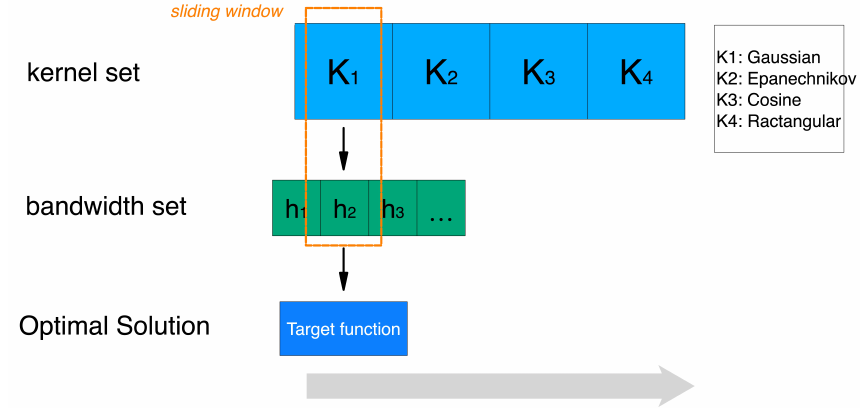
Figure 4. Two-step optimization for kernel density